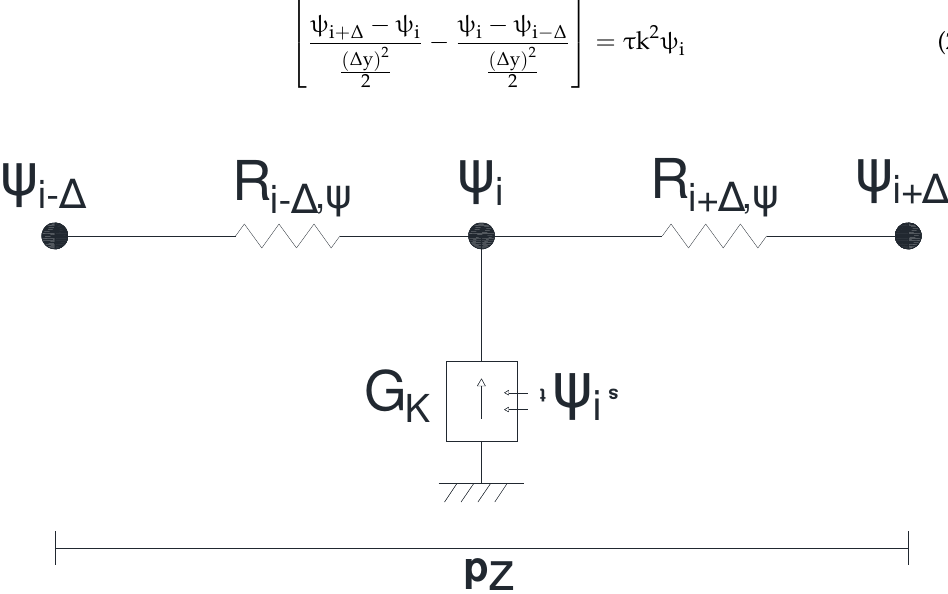
Figure 2. Nomenclature and network model of the ψ secondary circuit. Rectangular